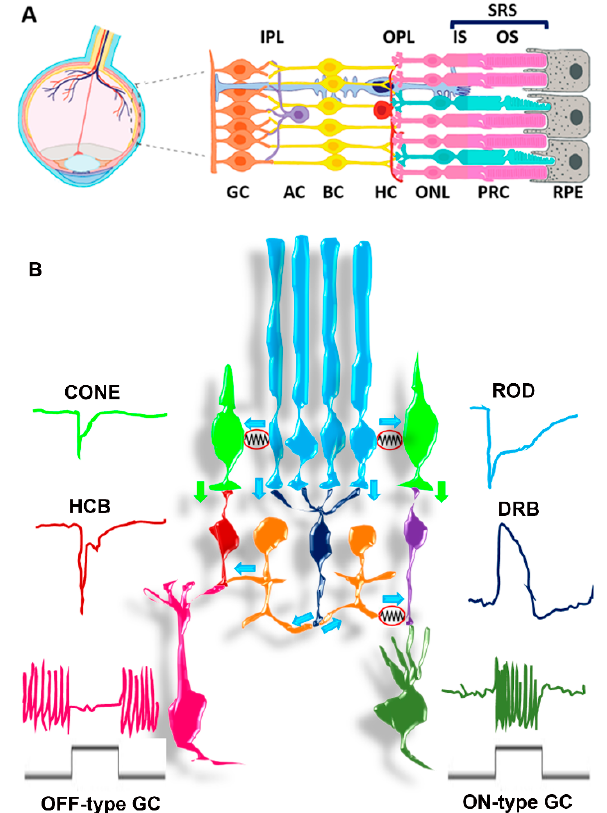
Figure 1. ( A ) In vivo cellular organization of the mature retina. The interactions occurring between distinct cell types and between photoreceptors and RPE are shown. GC: Ganglion Cells; AC: Amacrine Cells; BC: Bipolar Cells; HC: Horizontal Cells PRC: Photo Receptor Cells. IPL: Inner Plexiform Layer; OPL: Inner Outer Plexiform Layer. ONL: Outer Nuclear Layer; IS: Inner segment; OS: Outer Segment. The blue bar above IS and OS represents the SRS depth interposed between retinal pigment epithelial (RPE) cells and the end feet of Muller glial (MG) cells in the OR. The MG cell is shown in light blue and extends across the whole retina. ( B ) Parallel processing of PRC-generated signals by retinal networks. Cone cells (green) and hyperpolarizing response (on the left). Downward pointing green arrows: transfer of cone signals to hyperpolarizing CB (HCB) (red) and depolarizing CB (purple). Hyperpolarizing and depolarizing CB establish synaptic connection with OFF-type (pink) and ON-type (olive green) GC, respectively. Rod cells (cyan) and hyperpolarizing response to light on the right. Cyan arrows: transfer of rod-borne signals via primary and secondary rod pathways. Primary rod pathway: downward pointing cyan arrows indicate rod responses transfer to depolarizing rod BC (blue). Horizontal cyan arrows indicate the transfer of rod-borne signals to cone BC by AII AC (orange), via a chemical synapsis with HCB and an electrical synapsis (red circle containing a resistor symbol) with depolarizing CB. Secondary rod pathway: horizontal cyan arrows indicate the transfer of rod-borne signals to cones via electrical